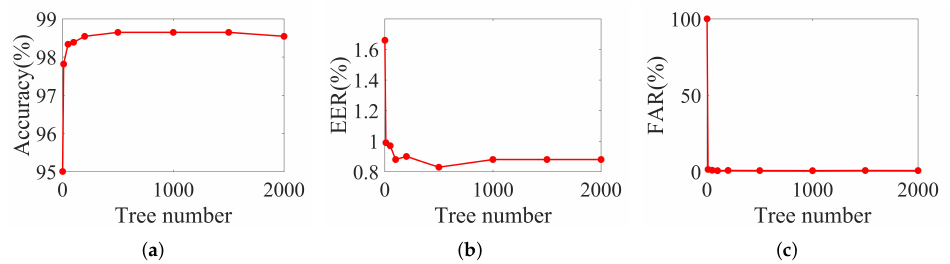
Figure 7. Performance of the proposed algorithm when using EER and FAR FRR = 1% for different decision trees. ( a ) Classification accuracy. ( b ) EER . ( c ) FAR